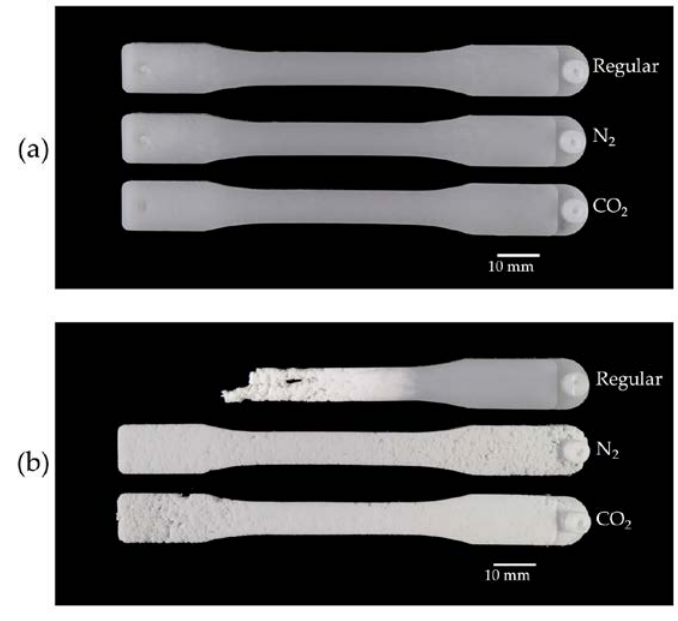
Figure 6. Images of injection-molded UHMWPE samples: ( a ) complete parts and ( b ) short-shot samples.